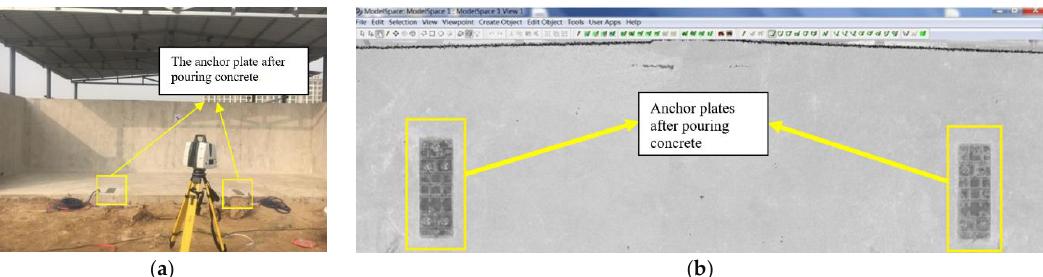
Figure 15. Scan of the anchor plate: ( a ) Scan anchor plate after pouring concrete and ( b ) anchor plate point cloud after pouring concrete.